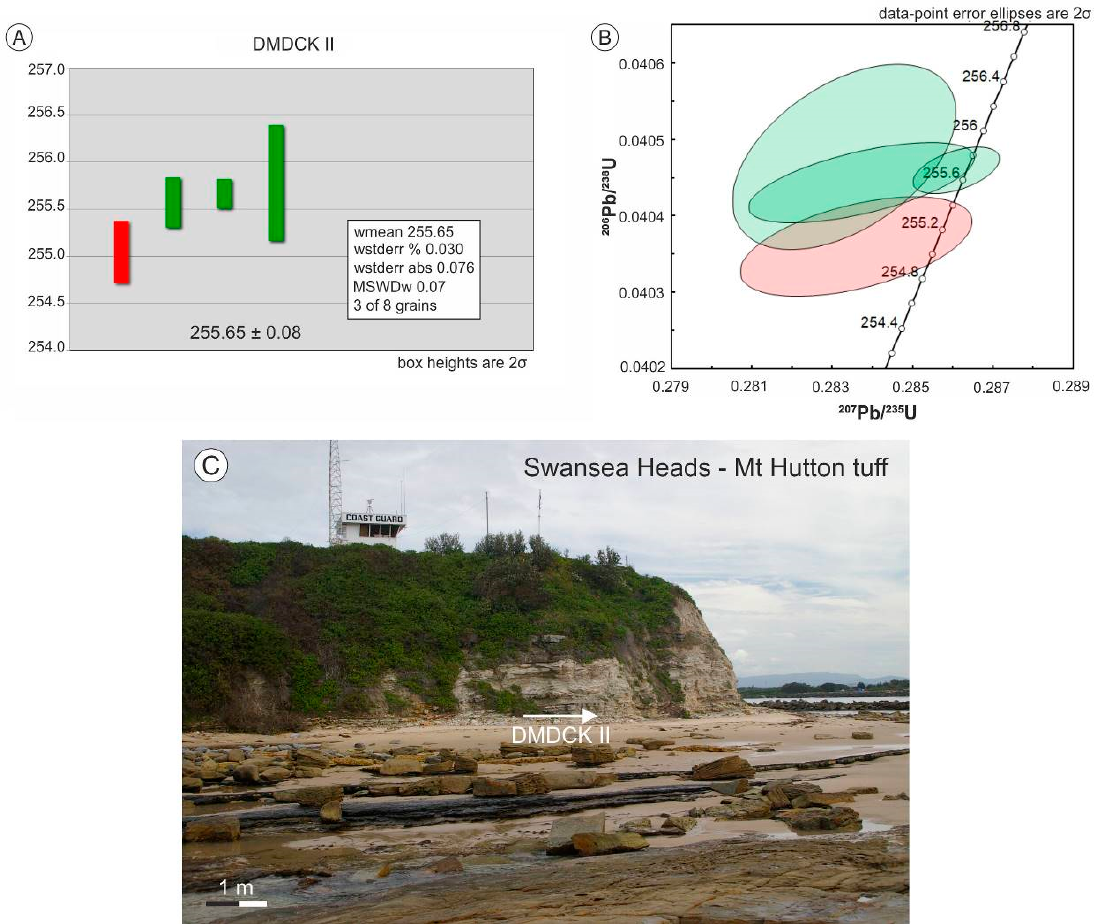
Figure 8. Weighted mean U-Pb CA-IDTIMS results of the selected samples in the study region (northern Sydney Basin). ( A ) and ( B ). Obtained zircon ages and Concordia plots of the tuff marker beds exposed at Swansea heads. ( C ) Outcrop photograph of the studied location illustrating the stratigraphic position of the selected tuff sample. Plots illustrate individual zircons (green) used in weighted mean calculation and rejected zircon ages (red). Uncertainties are 2 σ internal.